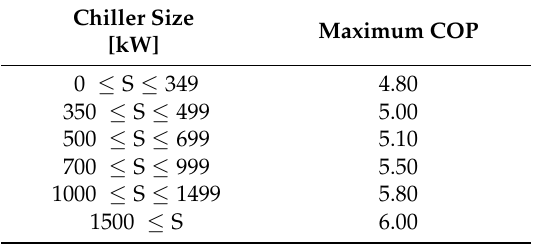
Table 3. Maximum coefficients of performance (COPs) for chillers of different